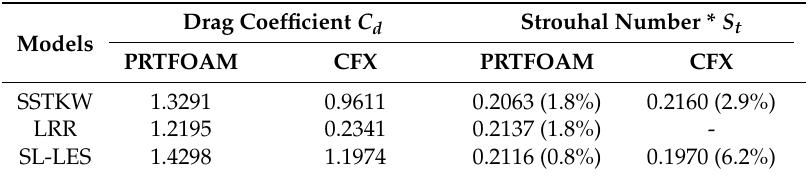
Table 3. The value of drag coefficient ( C d ), the value of Strouhal number ( S t ) in each turbulence model, and the relative error with Khan’s experimental values [32].